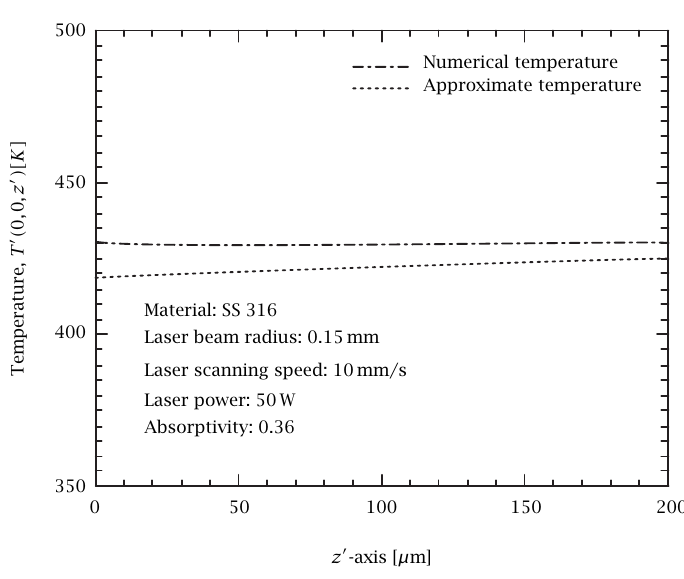
Figure 2.3 . Comparison between the numerical and approximate tempe- ratures ( r = 0 . 75mm case).